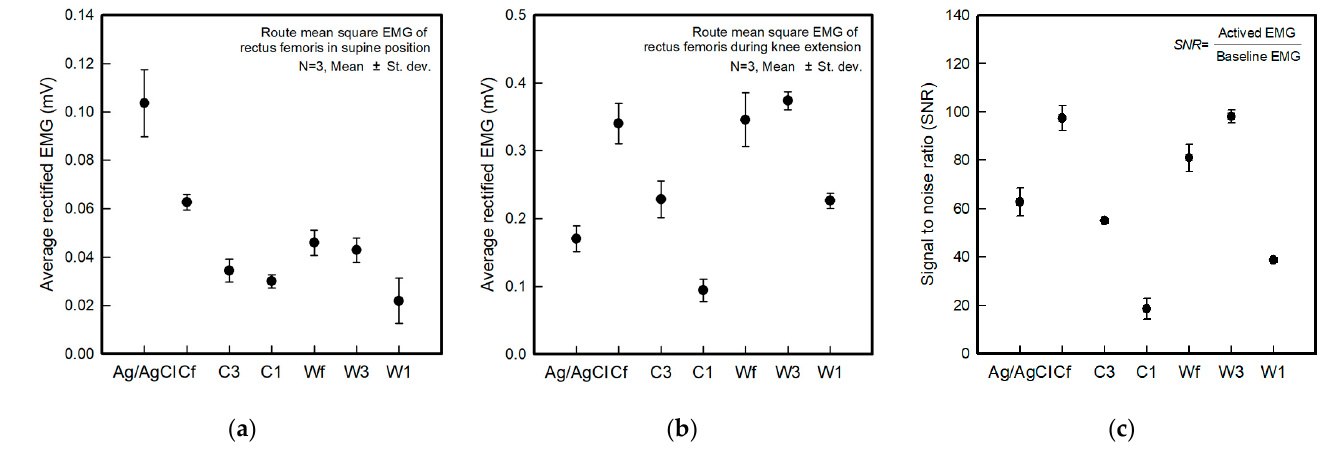
Figure 10. Average rectified sEMG of the baseline during muscle activation for different electrode types. ( a ) Baseline electrode noise; ( b ) sEMG amplitude during muscle contractions exerted by knee extension; ( c ) signal-to-noise ratio (SNR).